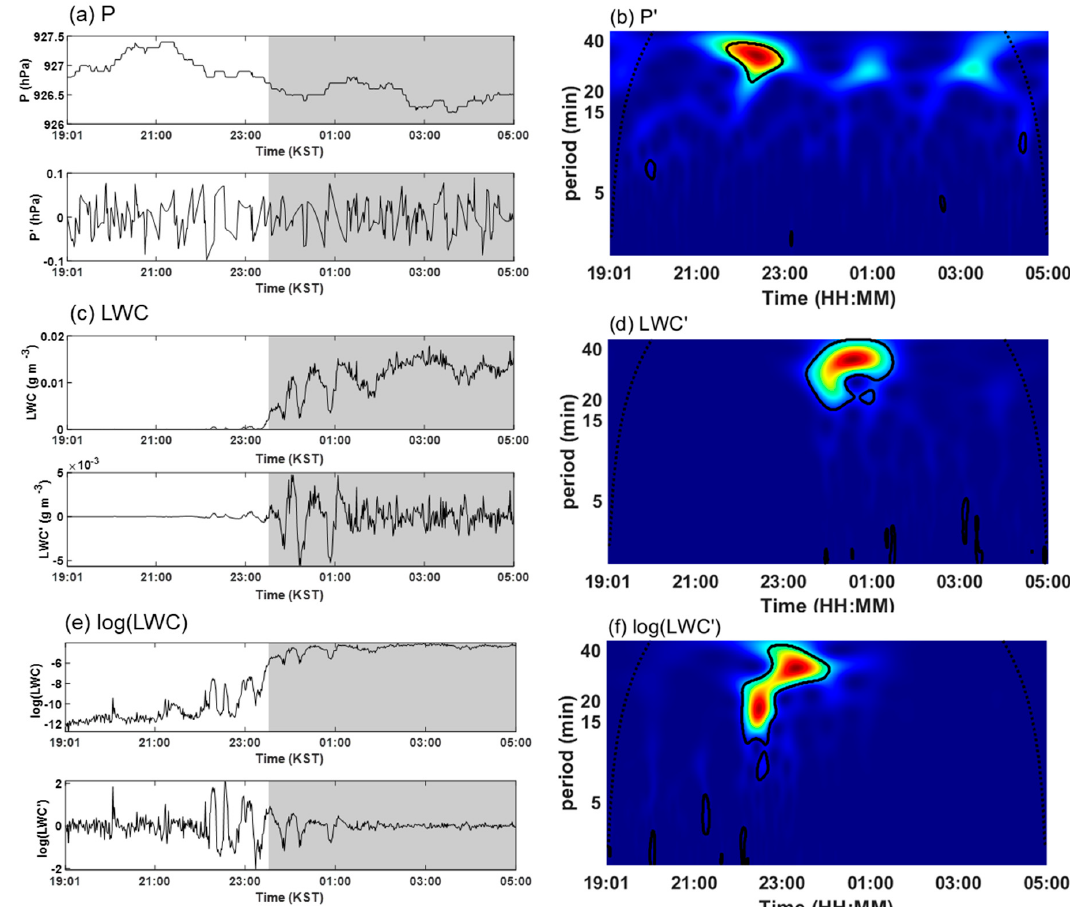
Figure 2. The time series data ( a , c , e ) and the local wavelet power spectrum ( b , d , f ) using the Morlet wavelet (Torrence and Compo 1998 [36]) for the filtered data averaged 1 min for 1900 08 Oct. 2017 - 0500 09 Oct. 2017 in Case 4: (a) Original (top) and filtered pressure p (cid:4593) (bottom), ( c ) Original (top) and LWC (cid:4593) (bottom), and ( e ) Original (top) and log( LWC (cid:4593) ) (bottom). The gray shading indicates the fog layer. The power is normalized by 1/ σ (cid:2870) . The thick contour encloses regions greater than the 0.1% significance level for a red-noise process. The dotted line is the cone of influence.